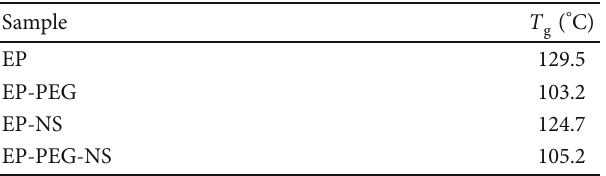
Figure 3: (a) Storage modulus and (b) tan δ versus temperature. Table 4: Glass transition temperature for all samples. Table 5: The tan δ curve peak of the samples.